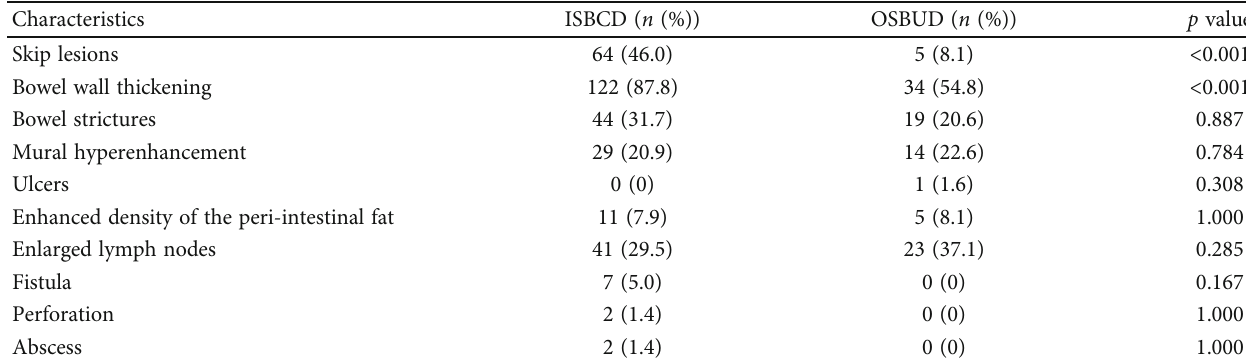
Table 4: Abdominal computed tomography.